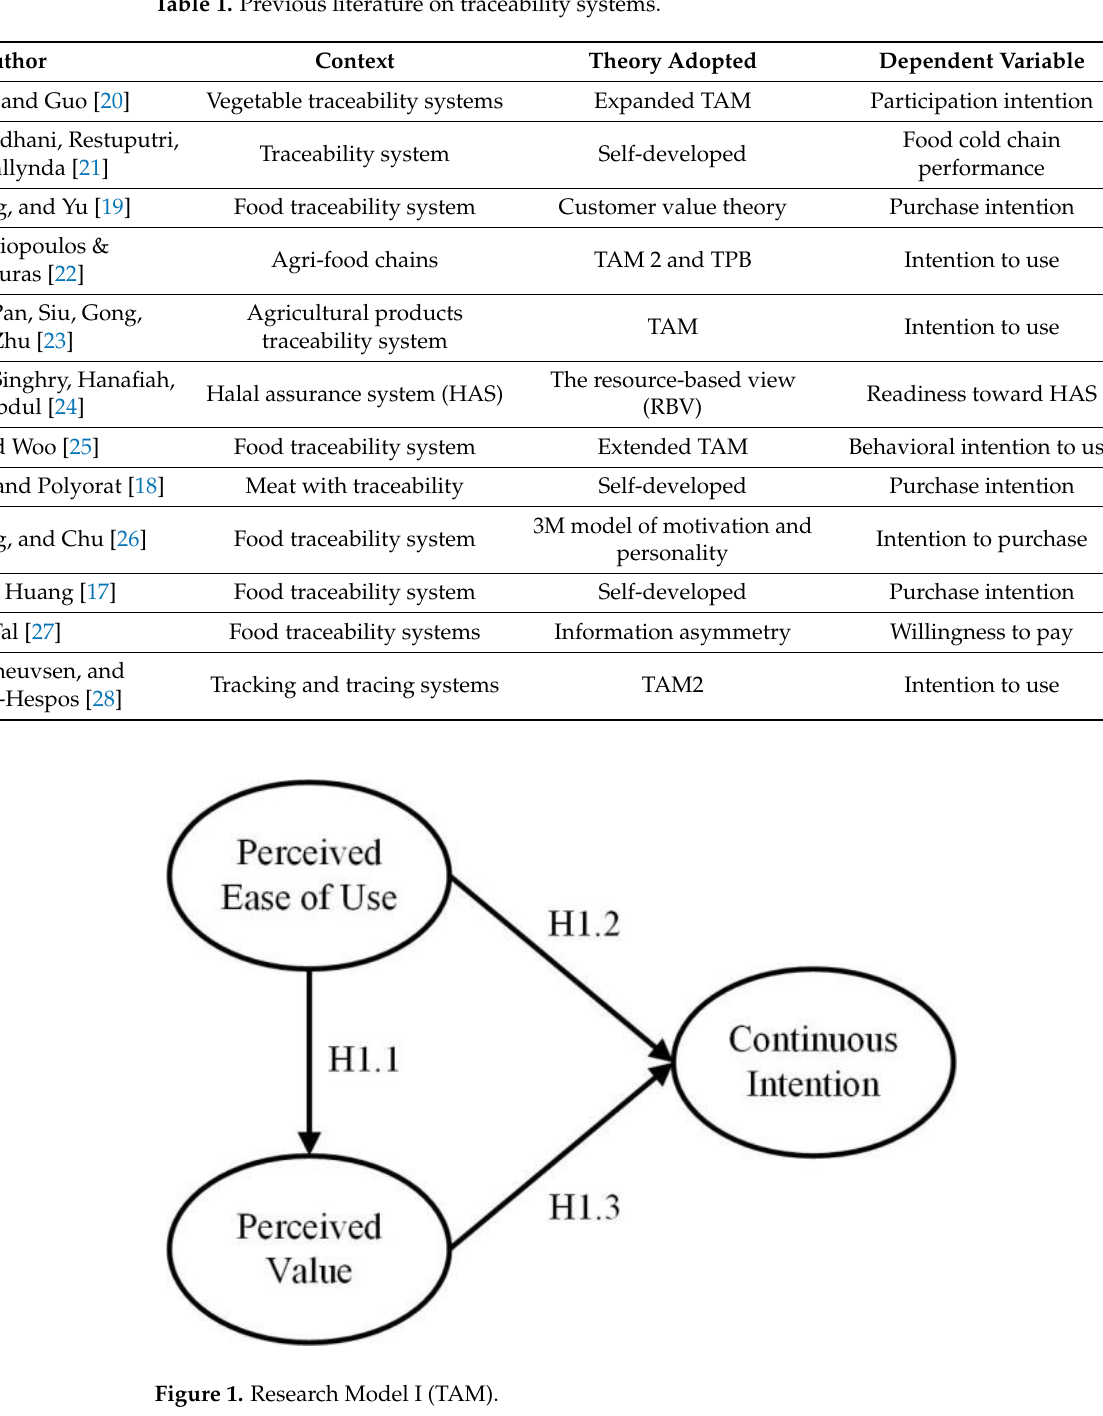
Table 1. Previous literature on traceability systems.